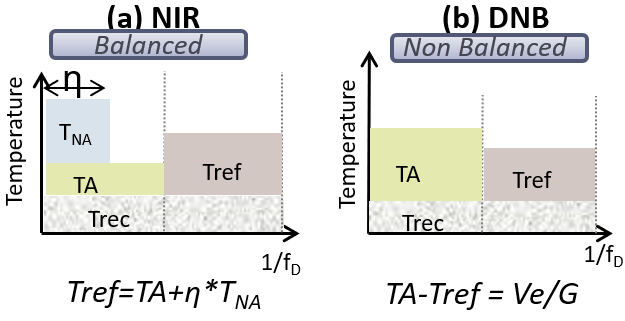
Figure 1. Schematic drawing of the operating